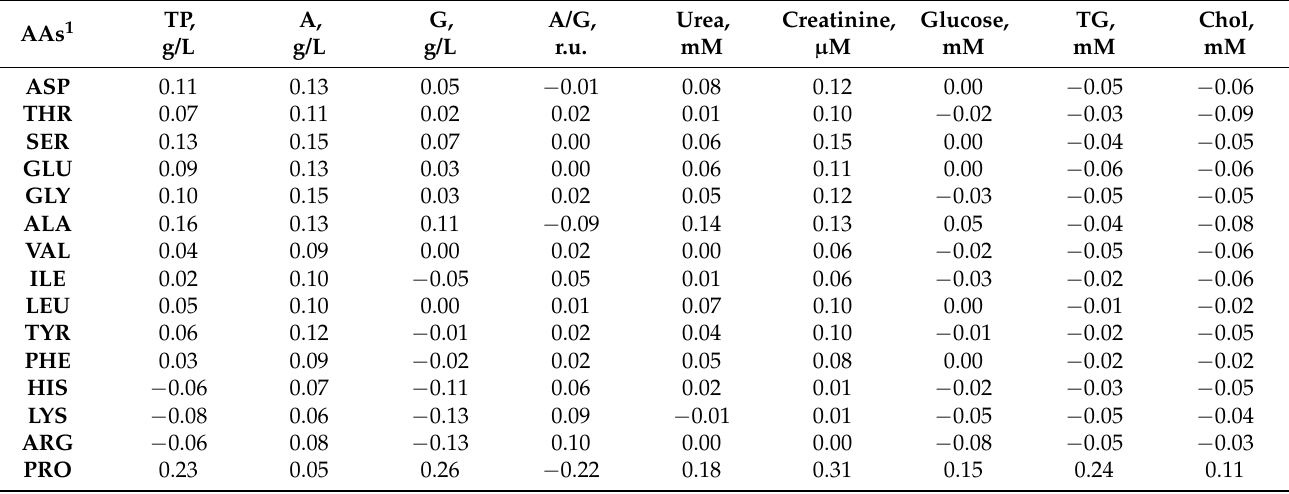
Table 4. The correlation coefficients between all obtained amino acids and the major biochemical parameters of the blood serum of Duroc pigs of the group 2 (72 days): TP, total protein; A, albumins; G, globulins; A/G, albumins to globulins ratio, urea, creatinine, glucose; TG, triglycerides; Chol, cholesterol (n =